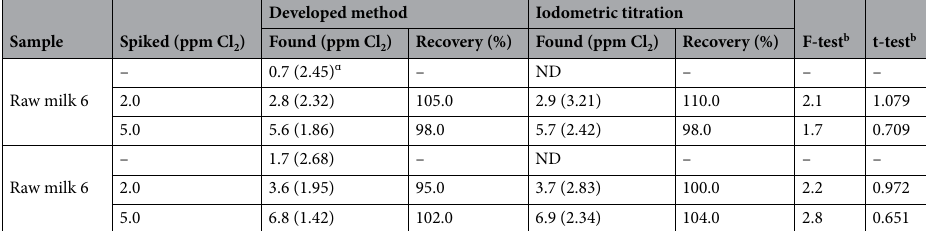
Table 4. The results of the spiked/recovery experiments conducted for the validation of the developed method for the determination of liquid bleach adulteration in milk (n = 3). ɑ Coefficient of variation. b F critical at